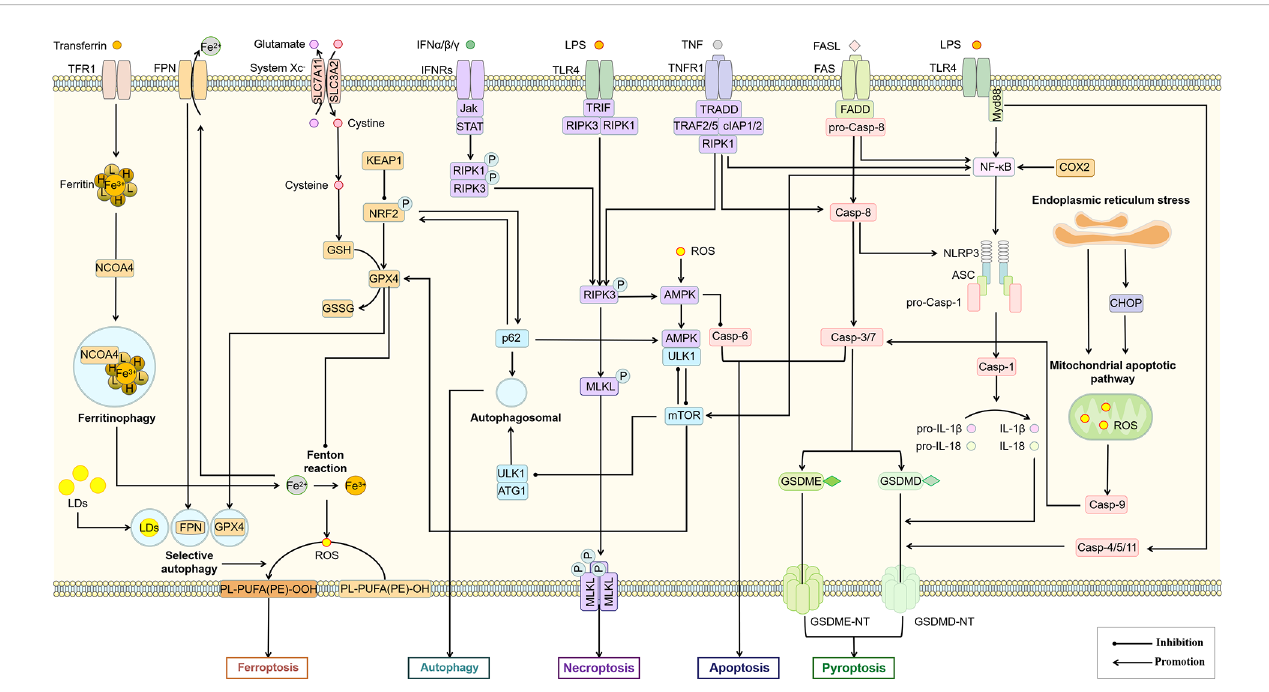
FIGURE 5 Association of different types of PCD in macrophages. The interaction between different PCD constitutes a complex regulatory network for survival or death of macrophages. AMPK, mTOR, Casp-8, RIPK3, Bcl-2 and p62 may be important nodes in the interaction of autophagy, apoptosis, necroptosis, pyroptosis and ferroptosis in this cell death network. ASC, apoptosis-associated speck-like protein; Casp, Caspase; CHOP, C/EBP homologous protein; cIAP, cellular inhibitor of apoptosis protein; COX-2, cyclooxygenase-2; FADD, Fas-associating protein with a novel death domain; FASL, Fas Ligand; FPN, ferroportin; GSDME, gasdermin E; GSH, glutathione; GSSG, glutathiol; IFN, interferon; Jak, janus kinase; KEAP1, kelch-1ike ECH-associated protein 1; LDs, lipid droplets; mTOR, mammalian target of rapamycin; Myd88, myeloid differentiation primary response 88; NCOA4, nuclear receptor coactivator 4; NLRP3, NOD-like receptor thermal protein domain associated protein 3; NRF2, nuclear factor erythroid 2-related factor 2; ROS, reactive oxygen species; SLC3A2, solute carrier family 3 member 2; TFR1, transferrin receptor 1; TNFR1, tumor necrosis factor receptor 1; TRADD, TNFR1-associated death domain protein; TRAF, TNF-receptor associated